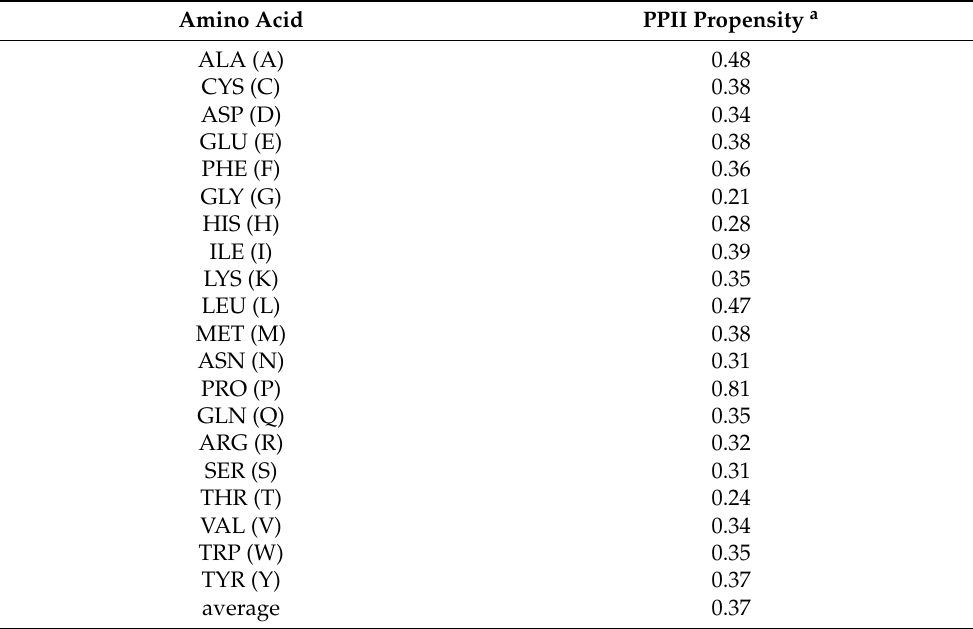
Table 3. Amino acid specific propensity for the PPII backbone conformation in the protein coil library.